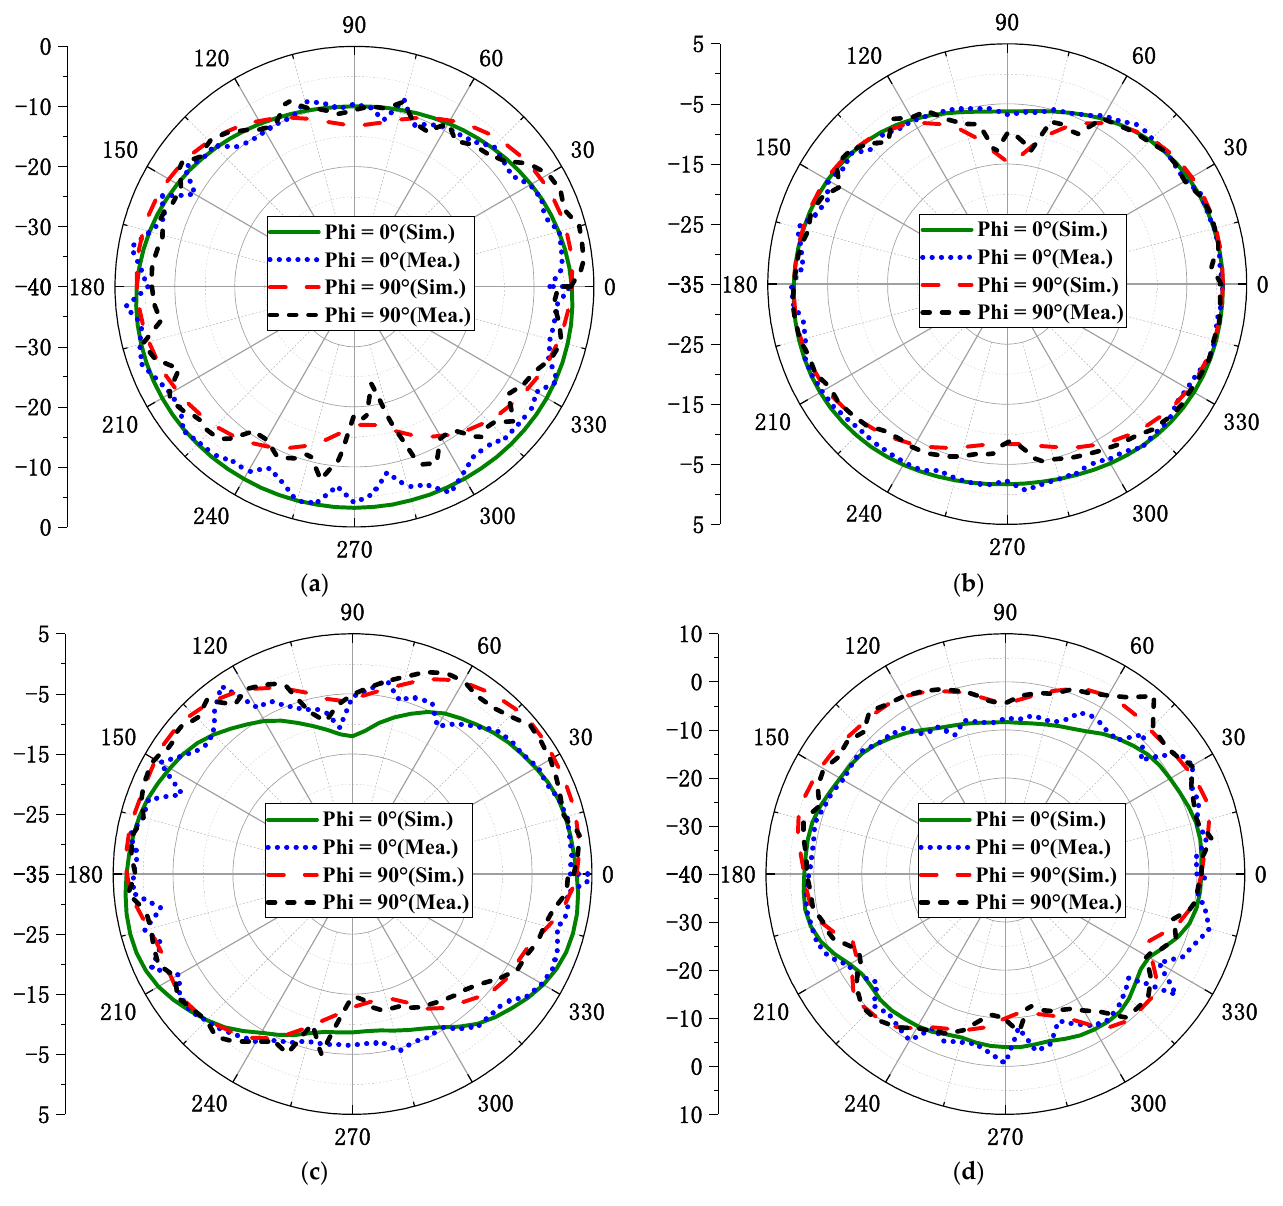
Figure 12. Simulated and measured radiation patterns of the proposed MIMO antenna in two main planes at: ( a ) 3 GHz; ( b ) 6.16 GHz; ( c ) 10.6 GHz; ( d ) 14.92 GHz.